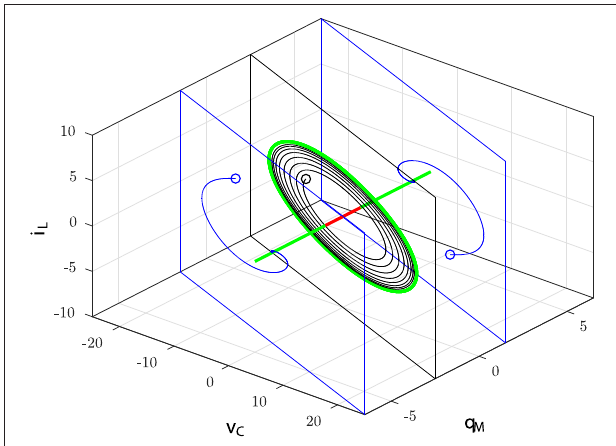
FIGURE 4 | Stable (green half lines) and unstable (red segment) equilibrium points: the trajectories starting on the planes with Q 0 < −¯ Q 0 and Q 0 > ¯ Q 0 converge toward the corresponding equilibrium points; the trajectory starting on the plane with Q 0 ( −¯ Q 0 , ¯ Q 0 ) converges toward the stable limit cycle ∈ (green).